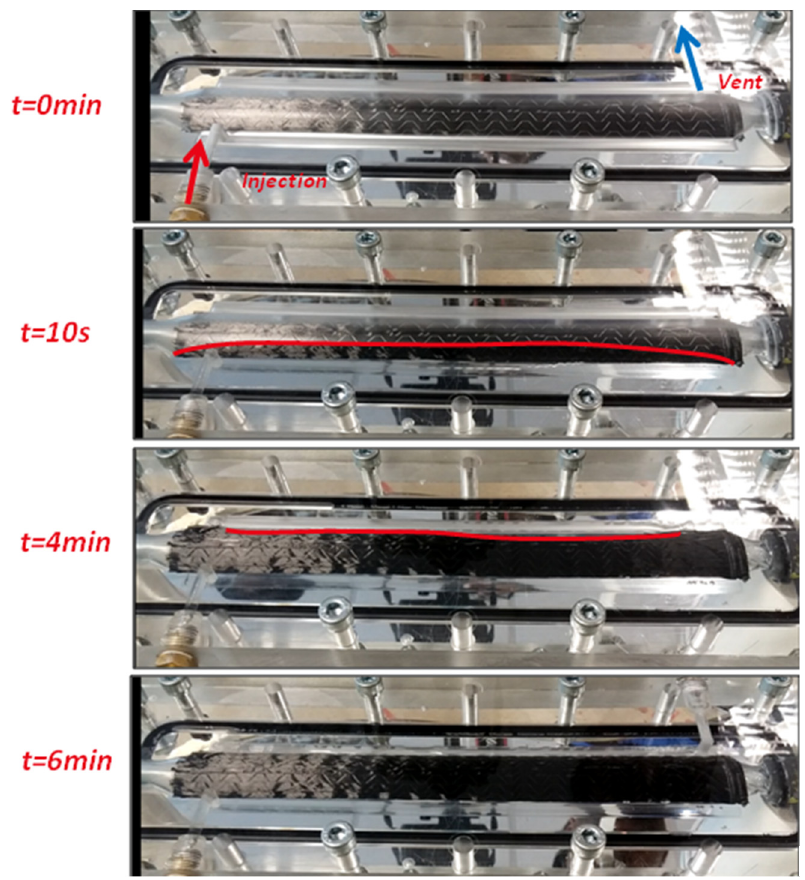
Figure 10. Flow front advancement for a tubular section using B-RTM process in an acrylic mold.